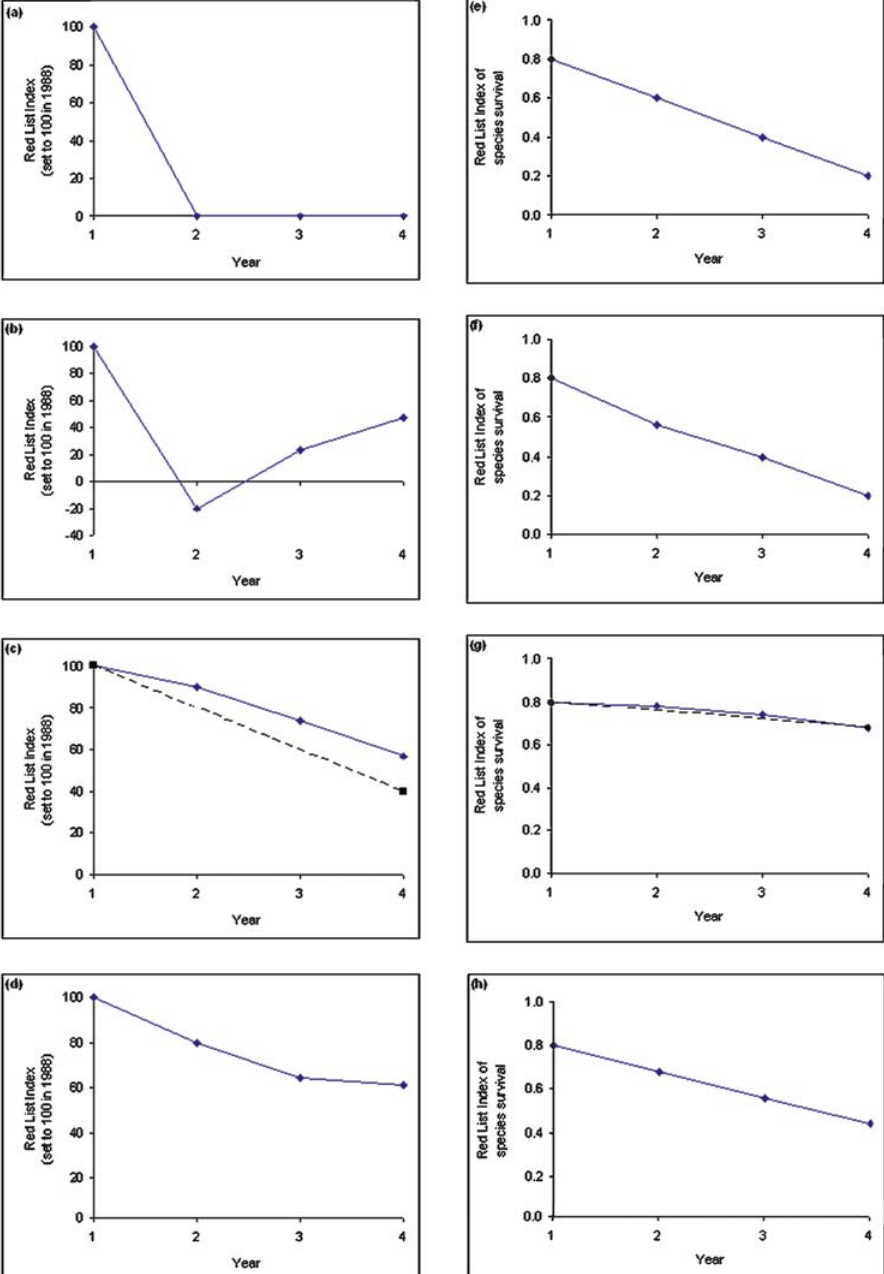
Figure 1. RLIs using the original formulation (left-hand graphs) and the revised formulation (right-hand graphs) for three hypothetical examples: (A and E) a set of five species, which are all classified as Near Threatened in year 1, Vulnerable in year 2, Endangered in year 3, and Critically Endangered in year 4; (B and F) the same scenario, except that one species jumps from Near Threatened to Vulnerable by year 2; (C and G) a set of ten Near Threatened species in year 1, with one species moving into Vulnerable in each subsequent year, and then up through the categories one step at a time each year thereafter; the dotted line shows the RLI as would be calculated if the same set of species were assessed for the IUCN Red List in years 1 and 4 only; (D and H) ten Near Threatened species that deteriorate by 0.1 category per species per year (i.e. one species per year moves up a category), plus ten Near Threatened species that deteriorate at ten times this rate (i.e. all ten species per year move up a category) and that are not assessed until year